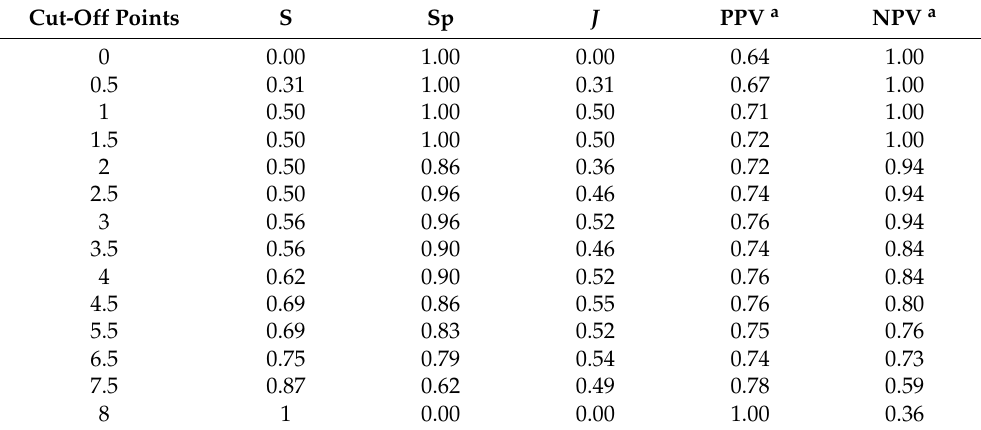
Table 7. Normative data of the PMIS-ID immediate total score for different cut-off points for AD in moderate level of ID